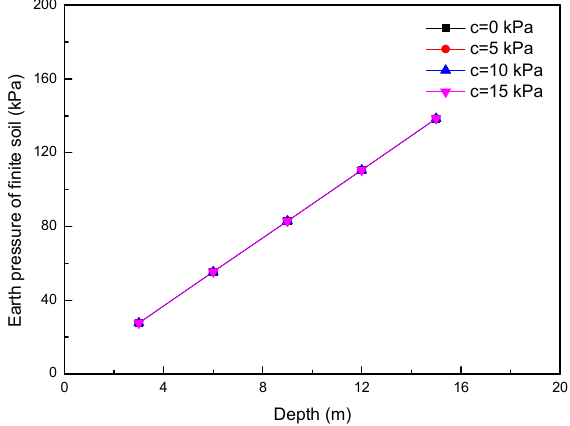
Figure 13. Influence of cohesion on earth pressure of finite soil.